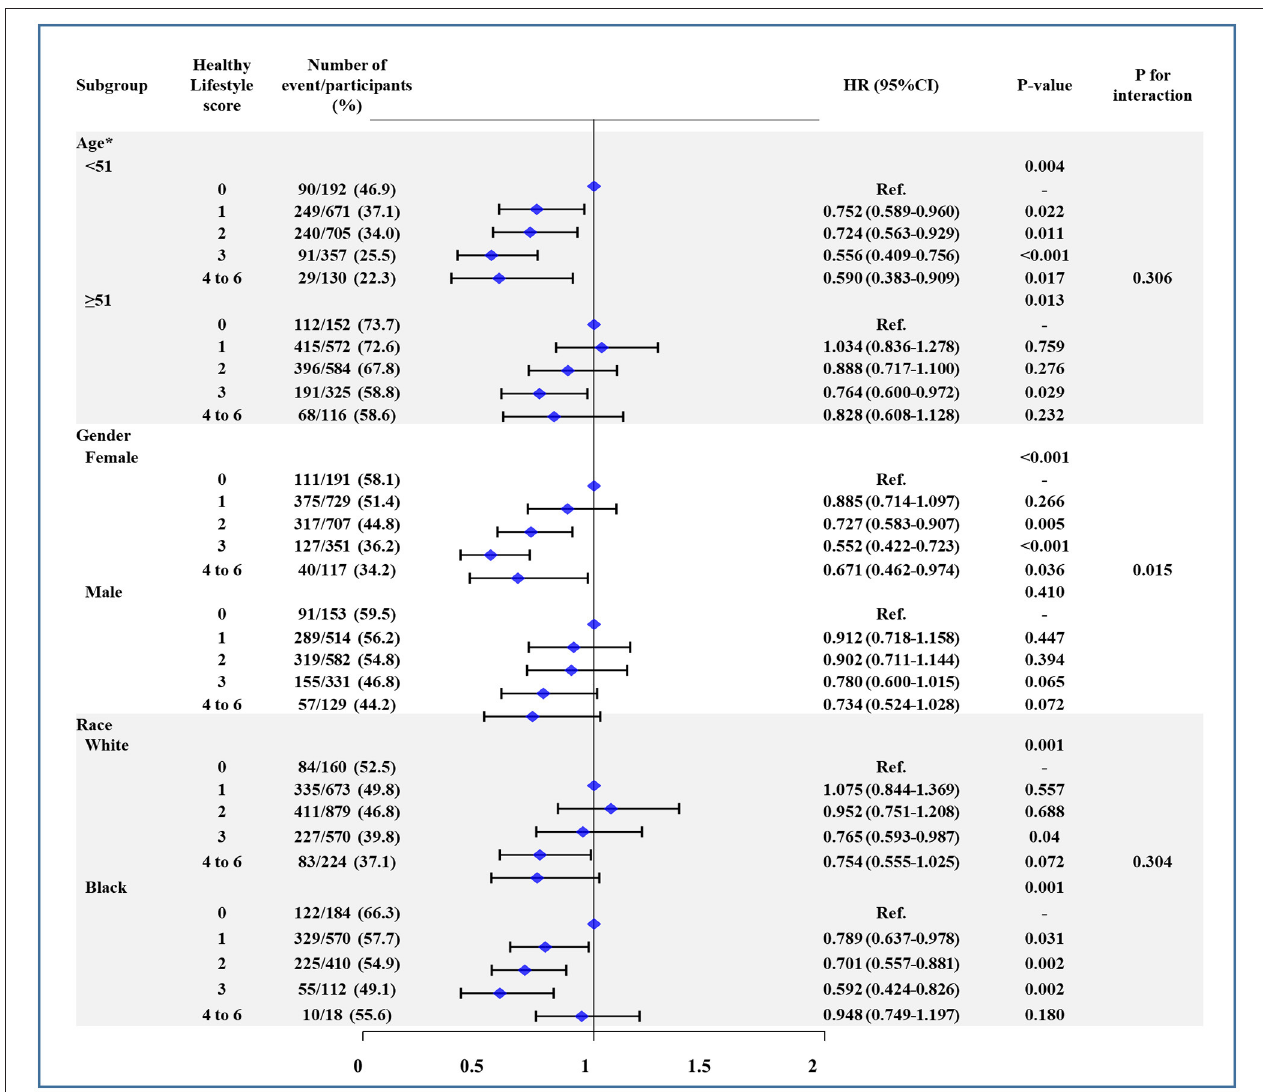
FIGURE 2 | The association between healthy lifestyle score (HLS) and all-cause mortality in subgroup of age, sex, and race. Age was divided by median. Models were adjusted by age, sex, center-race, education ( < high school, high school, or > high school), annual household income ( < 16,000; 16,000–35,000; > 35,000 US$), heart rate, systolic blood pressure, total caloric intake, total cholesterol, high density lipoprotein cholesterol, low density lipoprotein cholesterol, triglycerides, creatinine, and blood glucose. CI, confidence interval. HR, hazard